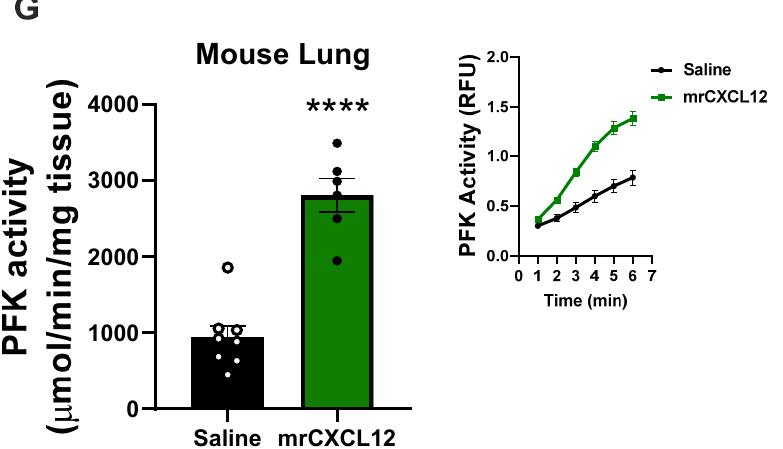
Figure 5. Subcutaneous CXCL12 infusion induced hallmark characteristics of PAH in female mice. ( A ) Mice infused with mrCXCL12 or vehicle control for 3 wks were analyzed for pulmonary arterial pressure changes (mPAP) via right heart catheterization. ( B – E ) Right and left ventricles were dissected away from the septum. Each were weighed to calculate relative heart chamber and total mass and Fulton Index. (n = 6–8). ( F , G ) Activity of ( F ) glutaminase and ( G ) phosphofructokinase (PFK) was quantified in lung lysates (n = 6–8). Results were analyzed by Student t-test. * p < 0.05, ** p < 0.01, **** p < 0.0001.